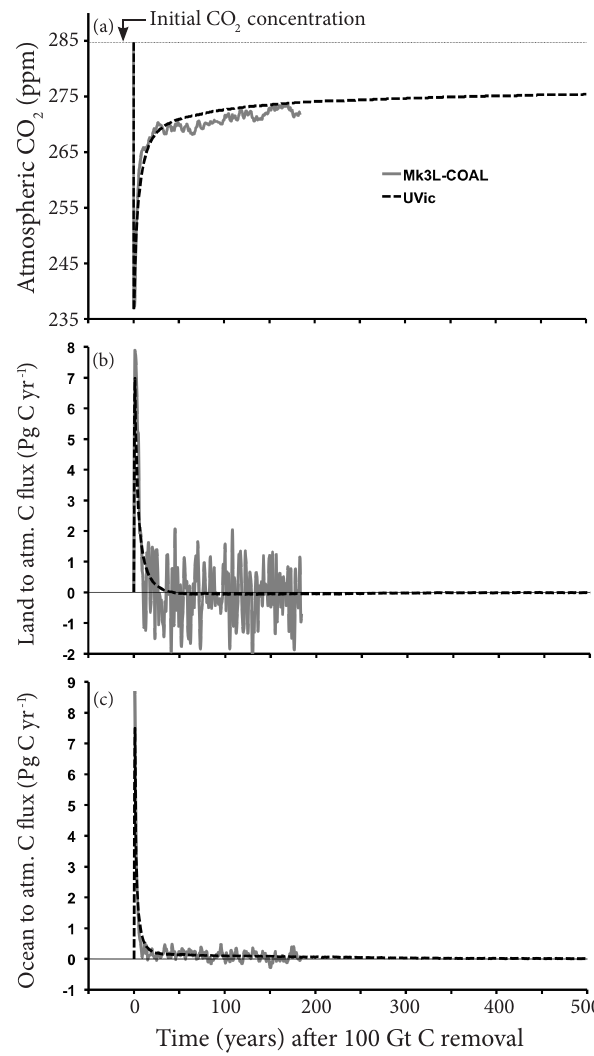
Figure 4. Exemplary instantaneous CO 2 removal from a preindus- trial climate experiment ( CDR-pi-pulse ) results from the esm-pi- cdr-pulse simulation with the Mk3L-COAL Earth system model and the University of Victoria (UVic) Earth system model of inter- mediate complexity (models are described in Appendix D). (a) At- mospheric CO 2 vs. time, (b) the land to atmosphere carbon flux vs. time, and (c) the ocean to atmosphere carbon flux vs. time. Note that the Mk3LCOAL simulation was only 184 years